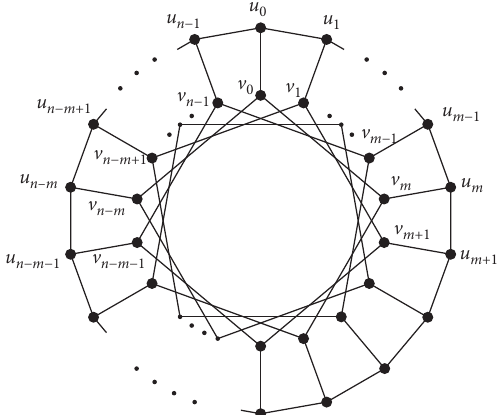
Figure 1: Generalized Petersen graph P ( n, m )